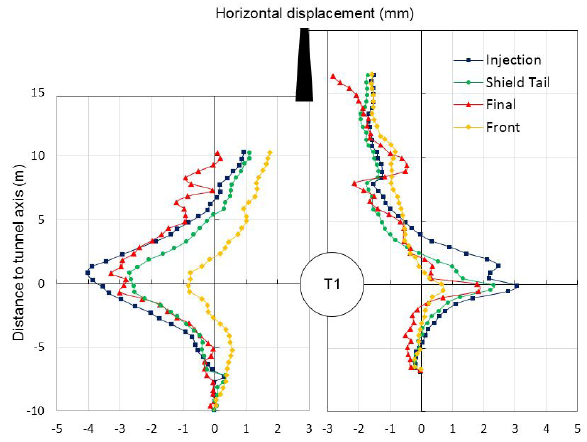
Figure 6: Lateral movements.